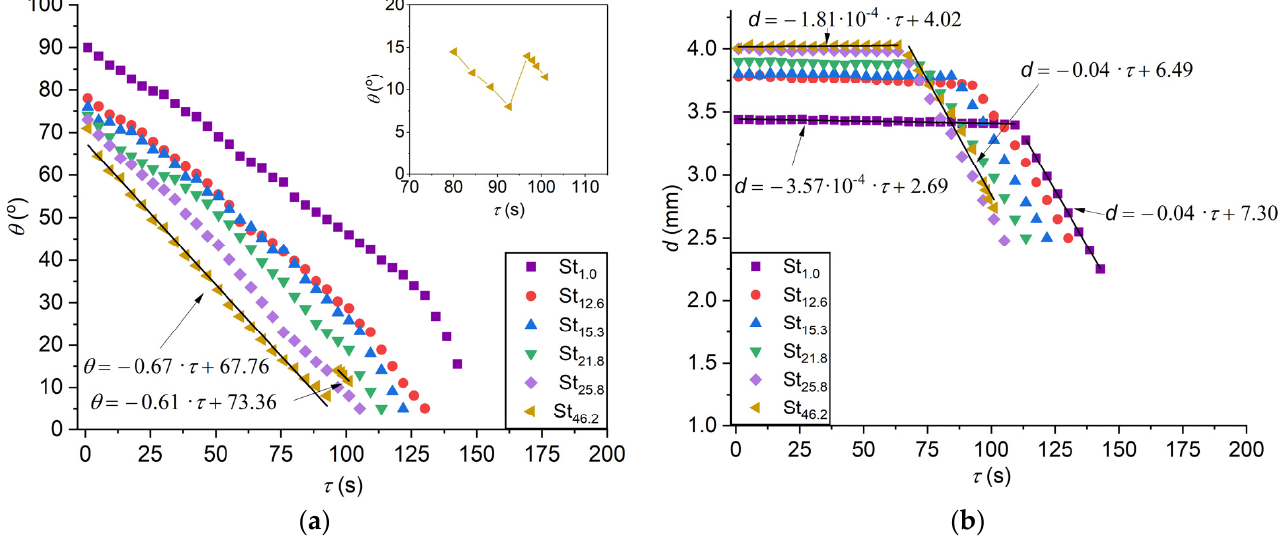
Figure 3. Contact angle ( a ) and diameter ( b ) versus evaporation time for water droplet evaporated in the single-phase regime on steel surfaces heated to 80 ° С .